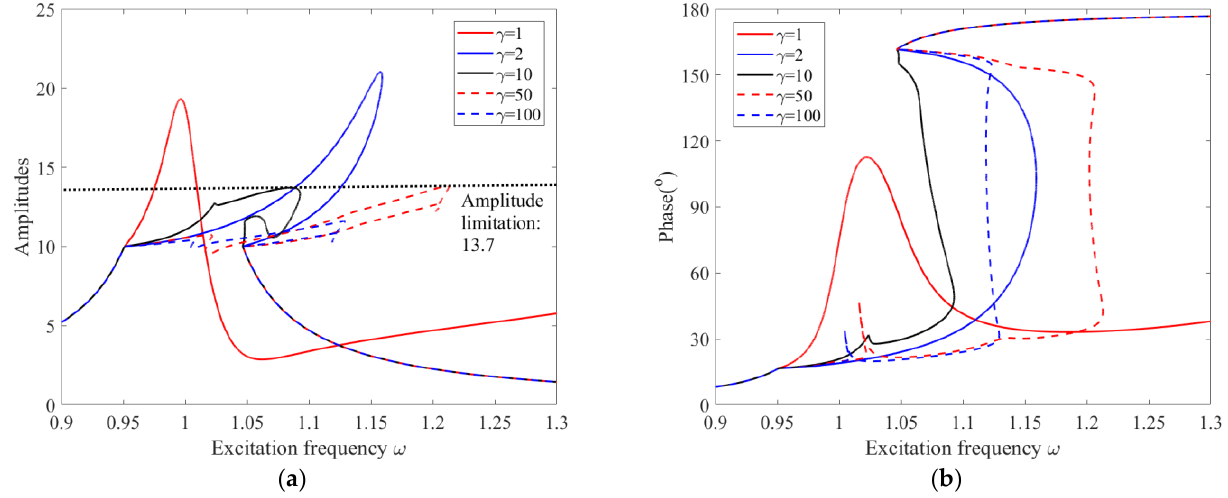
Figure 17. Influences of γ on amplitude–frequency and phase–frequency characteristics of Dof-1: ( a ) amplitude – frequency characteristics; ( b ) phase – frequency characteristics.